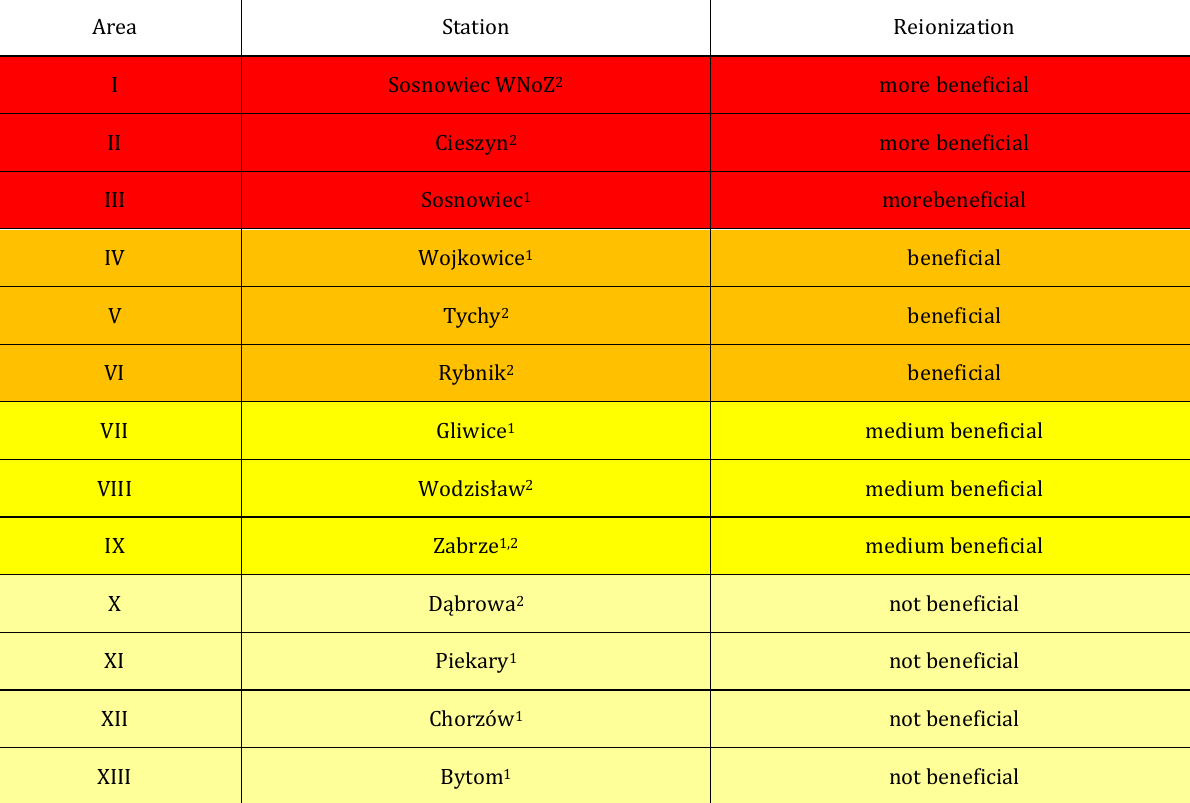
Table 4. Classification of stations with respect to the benefit of solar energy use